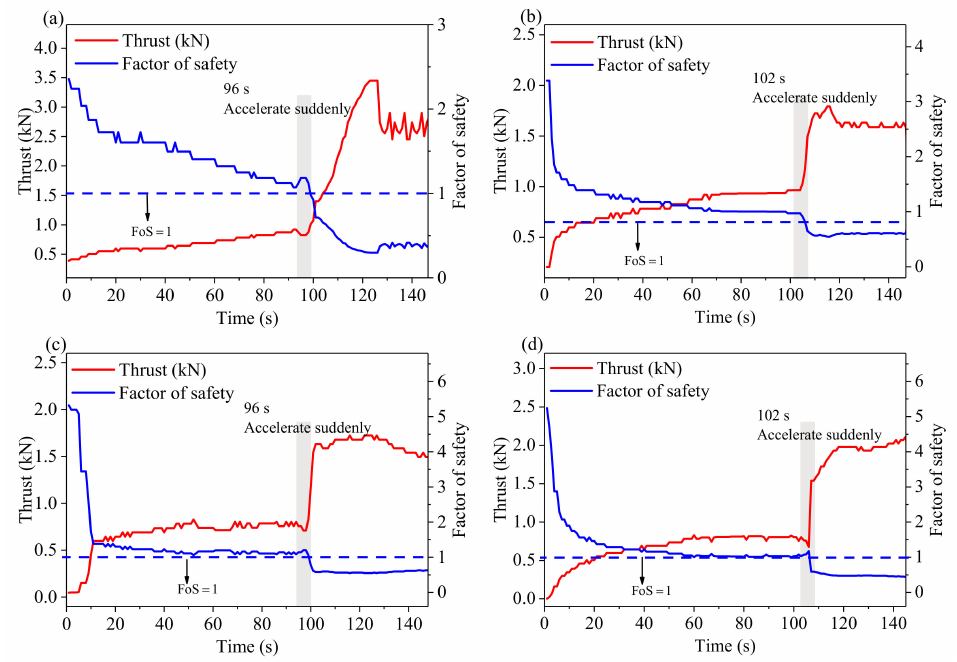
Figure 9. Thrust and factor of safety (FoS) plotted against time in ( a – d ) for the four experiments. All data points are the average value of 1 s.